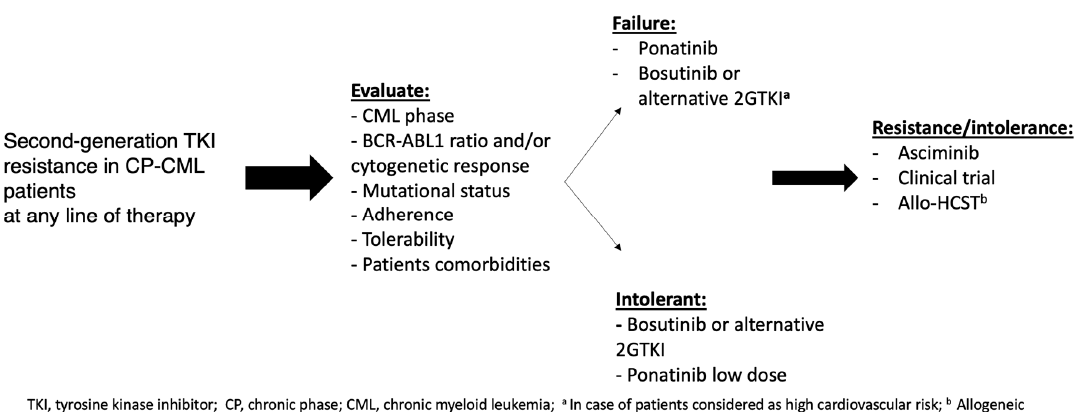
Figure 5. Treatment approach in CML patients failing 2GTKI. Allo-HCST = allogenic hematopoietic stem cell transplantation; 2GTKI = second generation tyrosin kinase